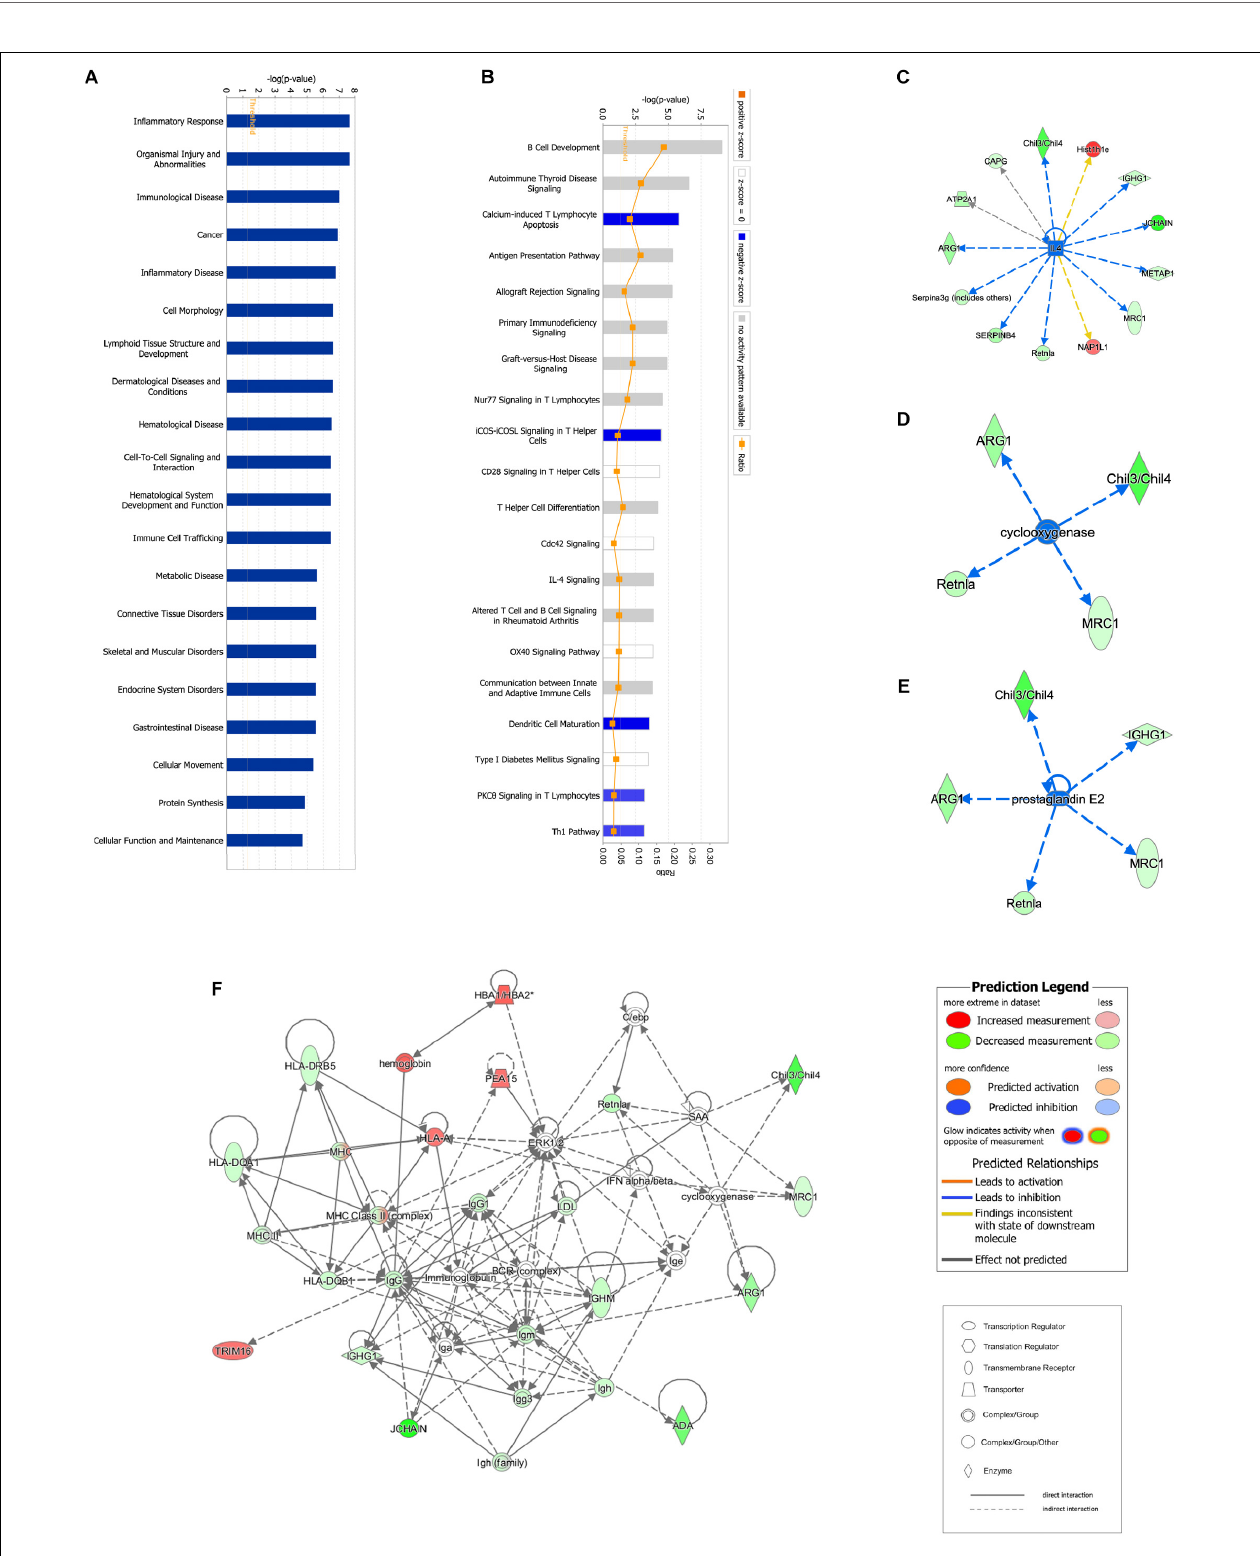
FIGURE 3 | Bioinformatic analysis of DEPs between the control and model groups using Ingenuity Pathway Analysis (IPA) and z -score algorithms. (A) Biological function enrichment. (B) Canonical pathways enrichment ( p -values for all functions and pathways presented are < 0.05). (C–E) Upstream regulatory factors predicted based on DEPs. (F) Relationships between DEPs and proteins predicted to be involved in interactions, as well as relevant signaling pathways, are presented. Statistical predictions of the networks were based on the Ingenuity Knowledge base. Red nodes represent upregulated proteins and green nodes represent downregulated